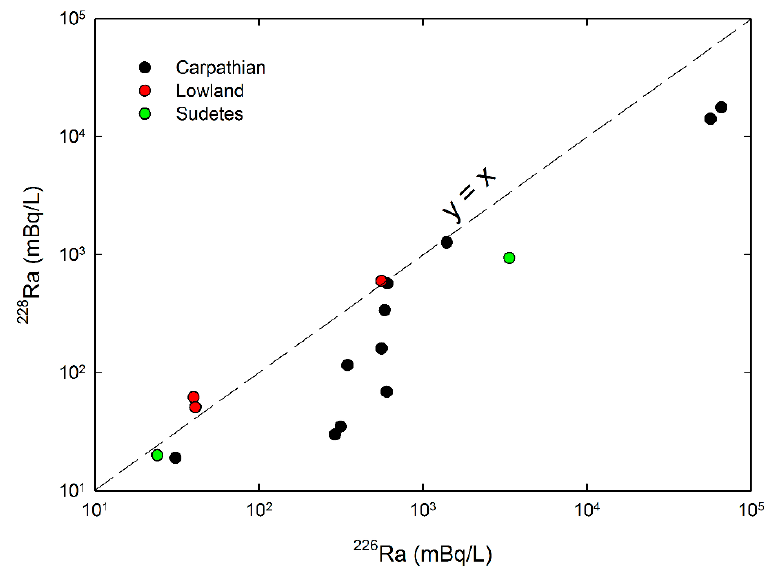
Figure 8. Relationship between 226 Ra concentration and 228 Ra concentration in the studied waters.